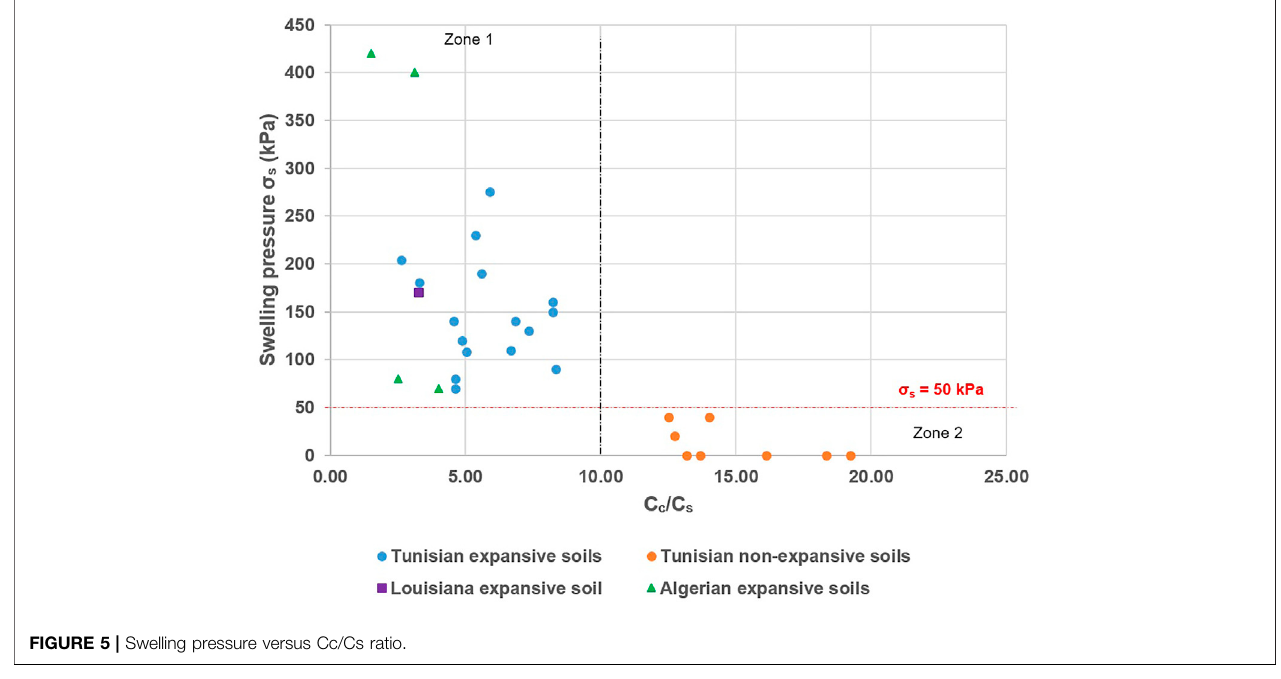
FIGURE 5 | Swelling pressure versus Cc/Cs ratio.